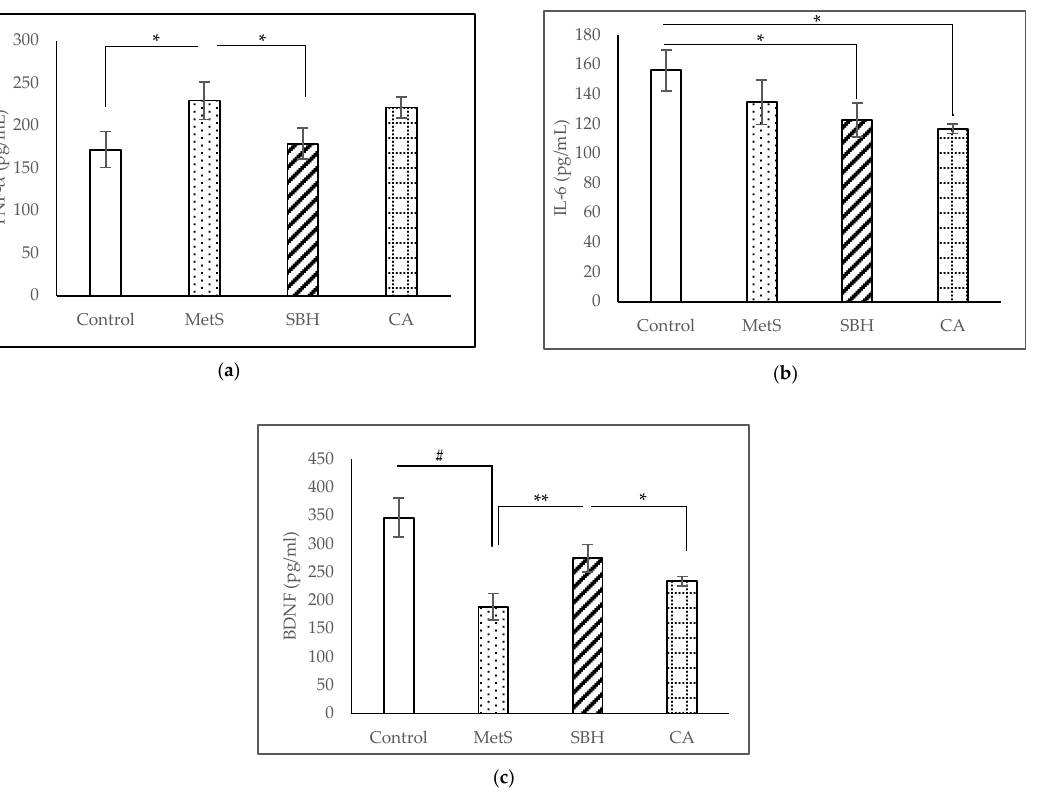
Figure 4. Effects of MetS induction and SBH and CA supplementation on homogenized brain tissue levels of ( a ) TNF- α ; ( b ) IL-6; and ( c ) BDNF. Data are presented as mean ± SEM ( n = 7). * p < 0.05; ** p < 0.01; # p < 0.001.